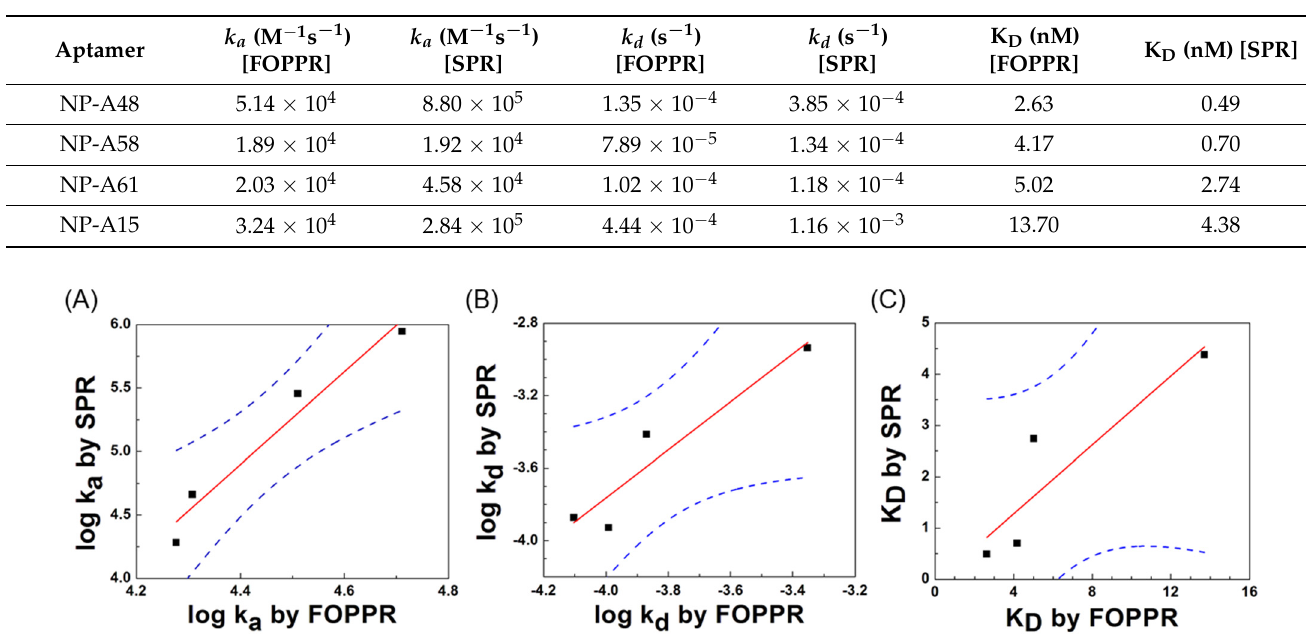
Figure 7. The linear correlations for ( A ) association rate constant, ( B ) dissociation rate constant, and ( C ) equilibrium dissociation constant, between the results obtained by FOPPR biosensor and SPR biosensor for the binding of each of the four ssDNA aptamers with the N-protein. Red solid lines are regression lines and black dashed lines are the 95% confidence intervals for prediction with the linear regression model.